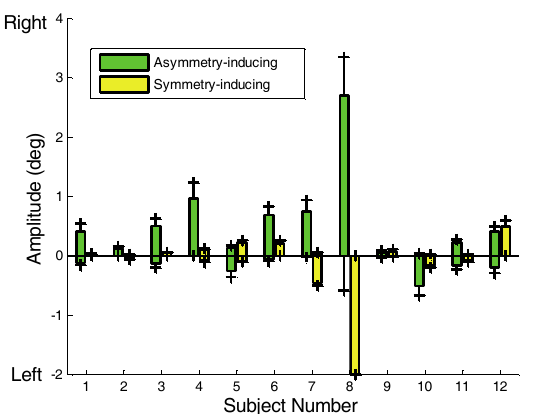
Figure 7 The average amplitude or asymmetry-inducing (green) and symmetry-inducing (yellow) saccades. The marks at the top or bottom of each bar indicate one standard deviation. Over all subjects, the amplitudes of asymmetry-inducing saccades are significantly larger than symmetry-inducing saccades (p < 0.025)